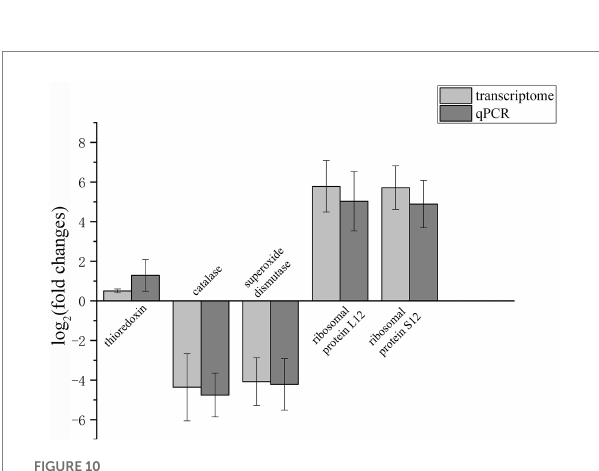
FIGURE 10 Validation of transcriptomic data by qRT-PCR of five selected genes. β -Tubulin was selected as the reference gene. The upregulation and downregulation of gene expression are shown above and below the X-axis,